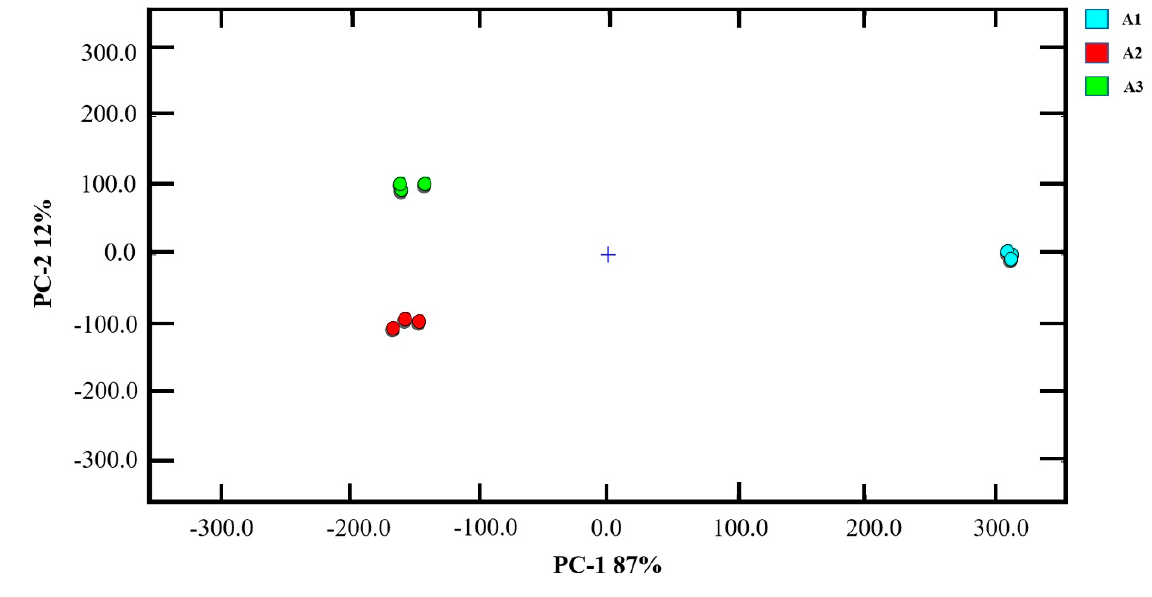
Figure 3. PCA analysis of GC-IMS.